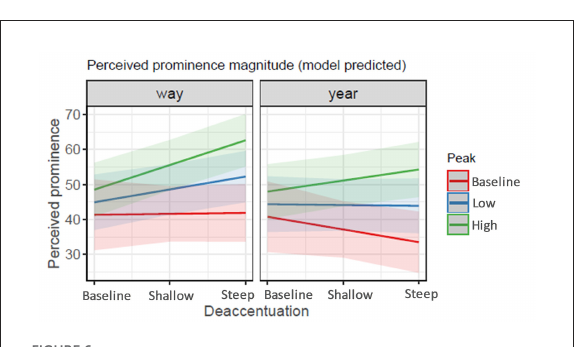
FIGURE6 Predicted values of perceived prominence (Test 1). Shaded areas represent 95% confidence